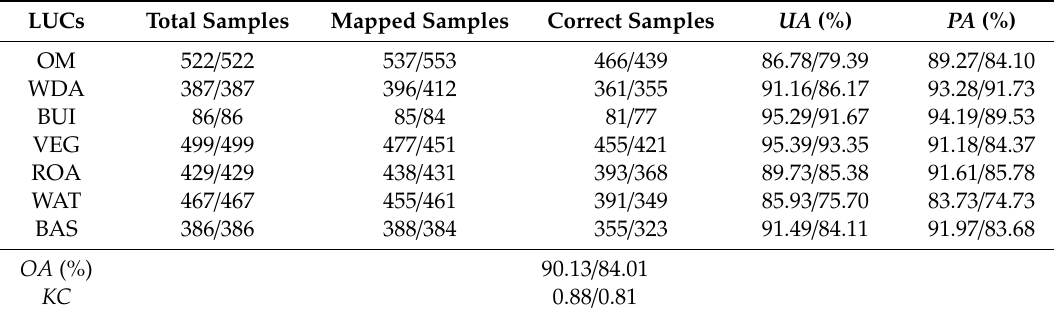
Table 6. Accuracy assessment of OMM results of CNN /